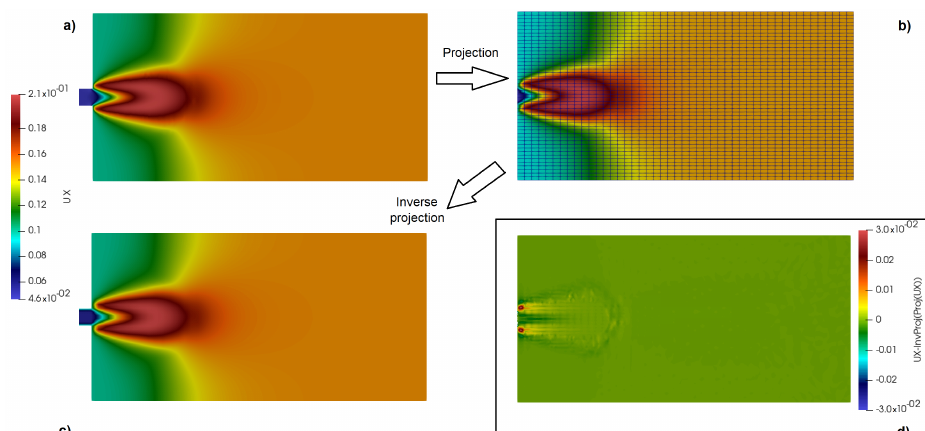
Figure 5. Illustration of the VAE architecture.